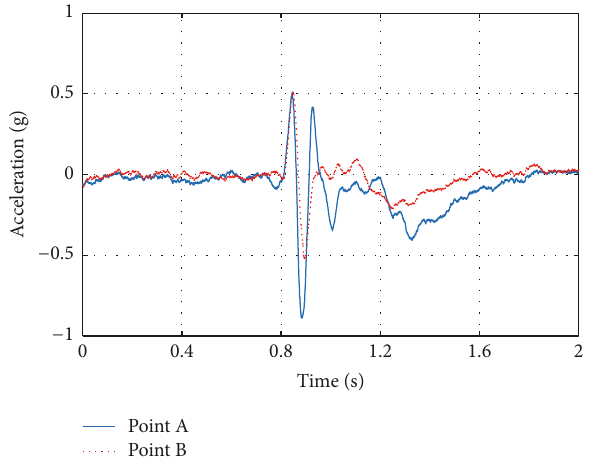
Figure 11: Sinusoidal vibration response spectrum in the 𝑥 direc-